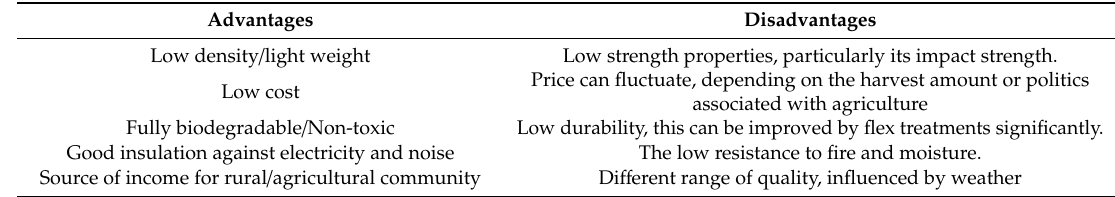
Table 1. Advantages and disadvantages of natural fibers